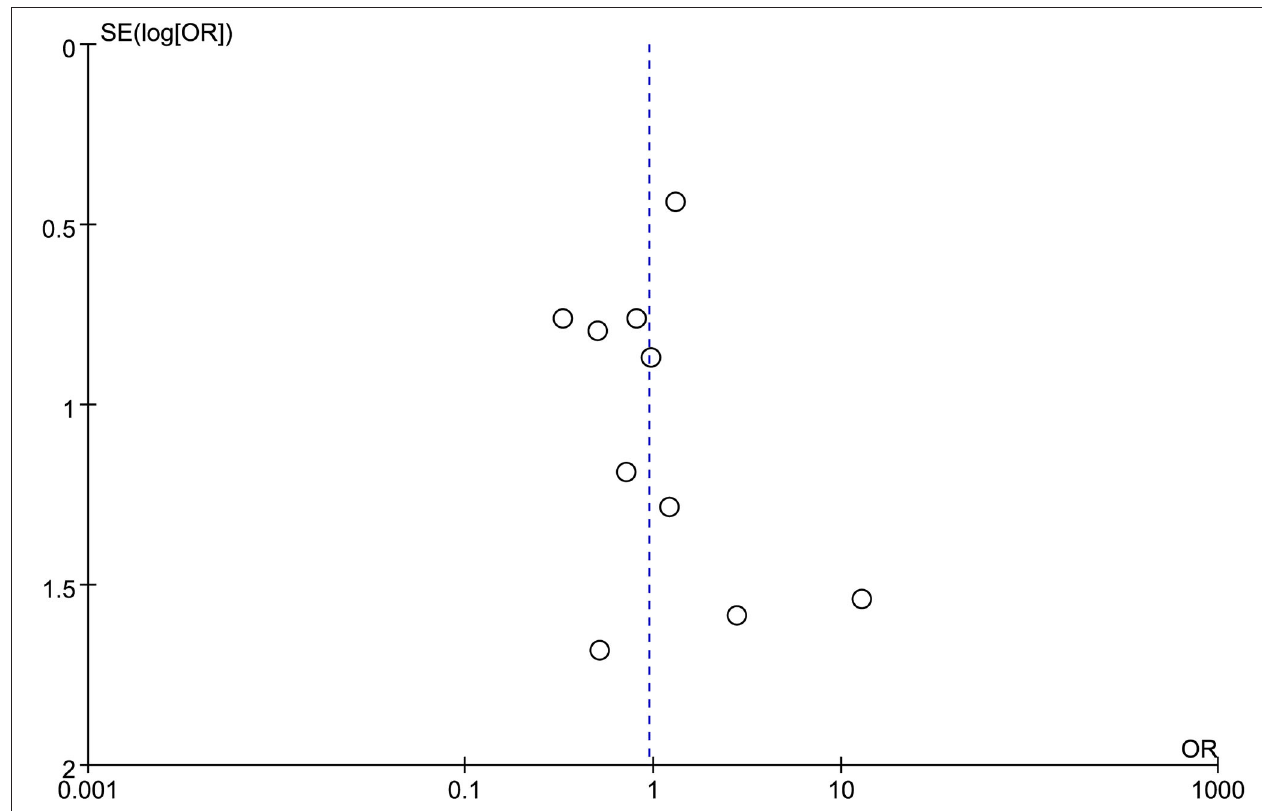
FIGURE 5 | Funnel plot of clinical success between EUS-CDS and EUS-HGS.